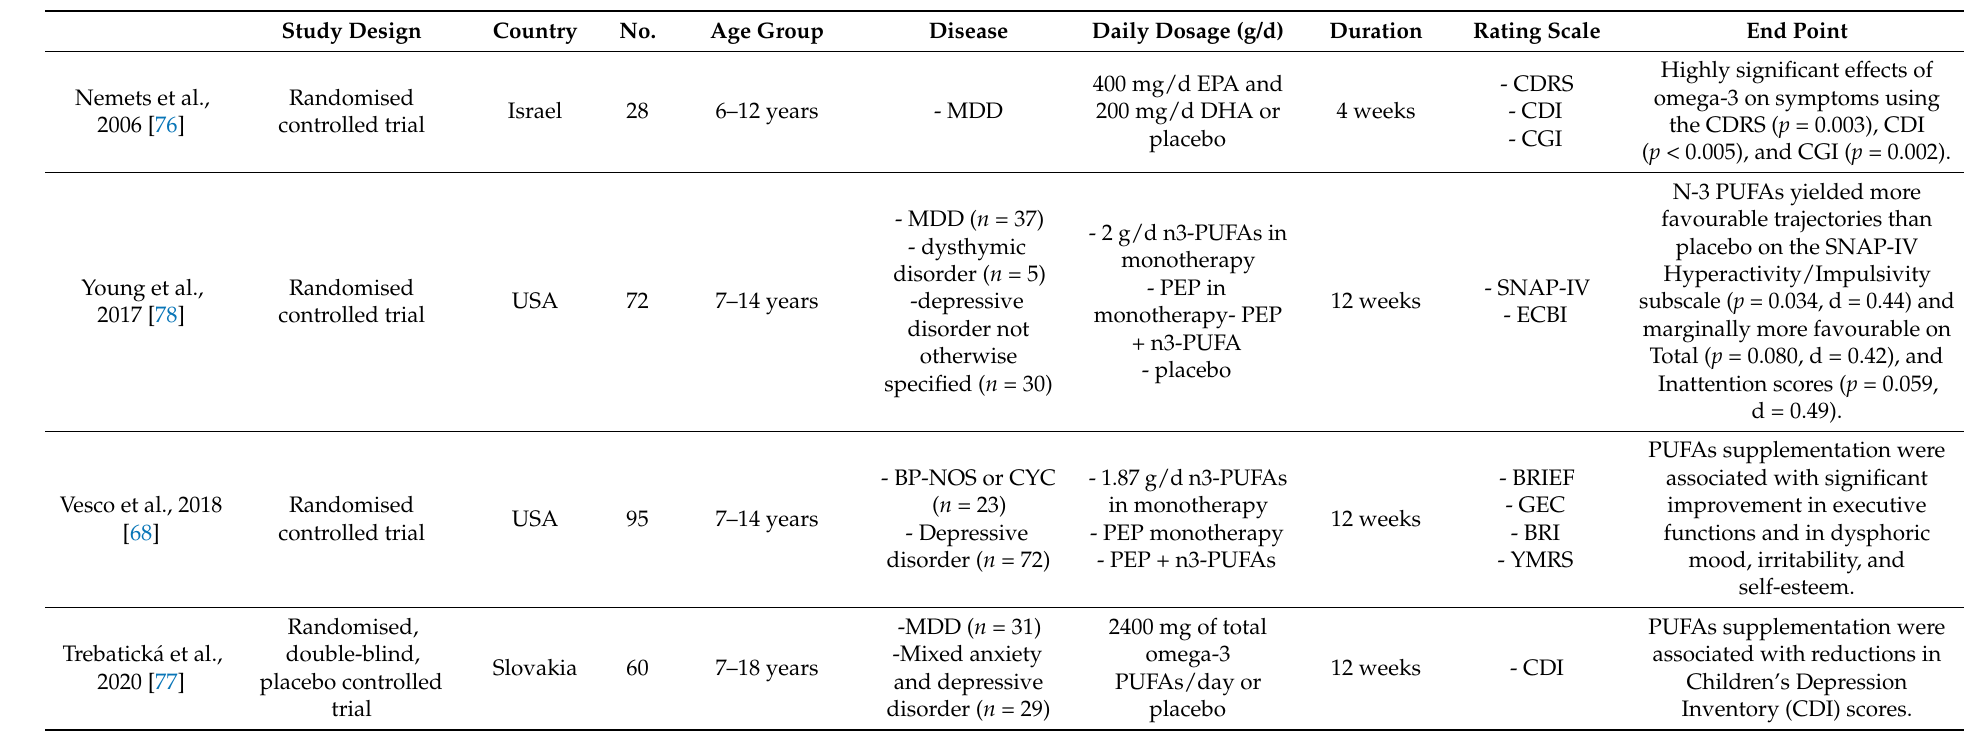
Table 3. Depressive